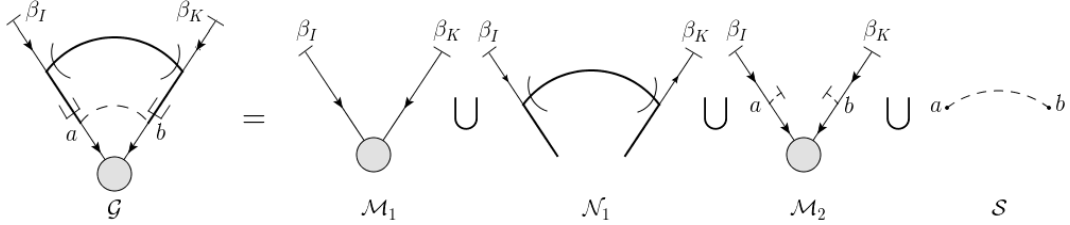
Figure 19. The decomposition of a pinch surface with hard-exotic con(cid:12)gurations (represented by G ) into several subgraphs M 1 , N 1 , M 2 and S